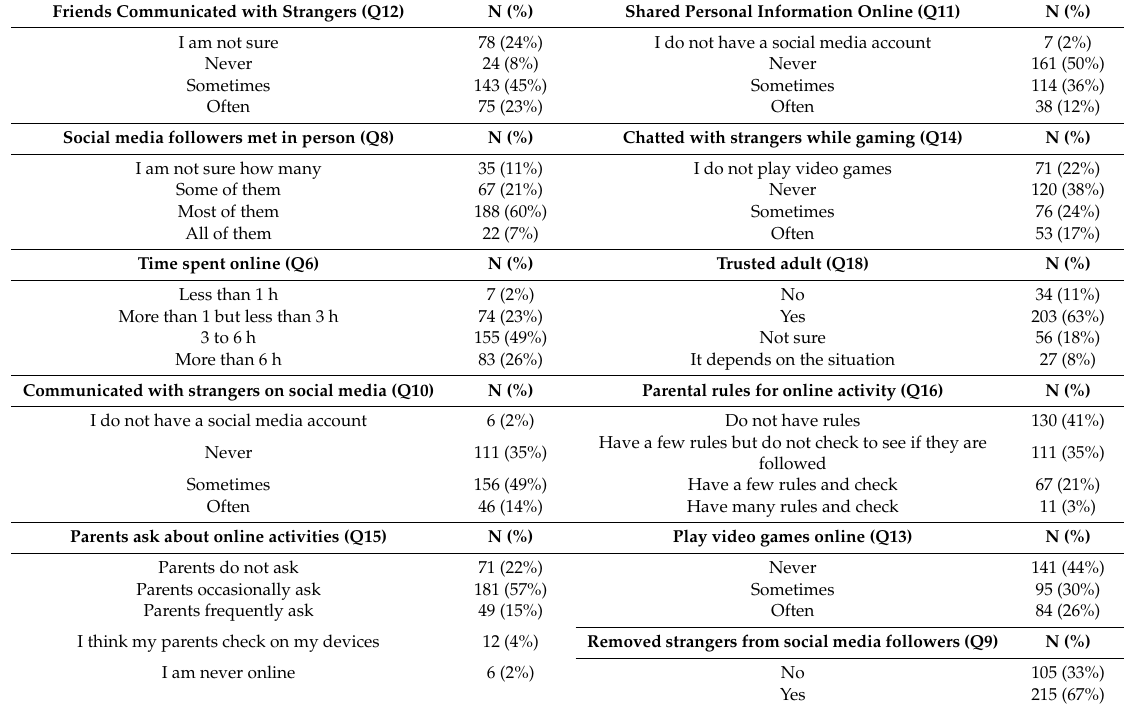
Table 1. Students’ Online